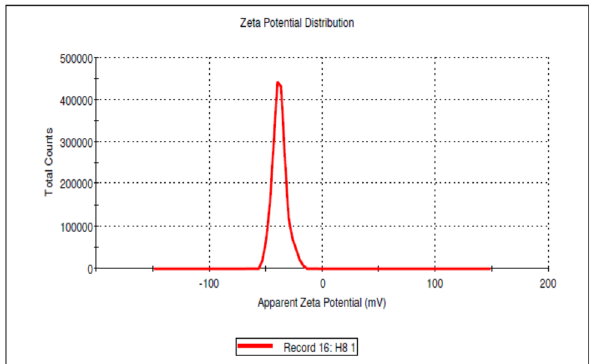
Figure 6: Zeta potential spectrum of synthesized Cs -